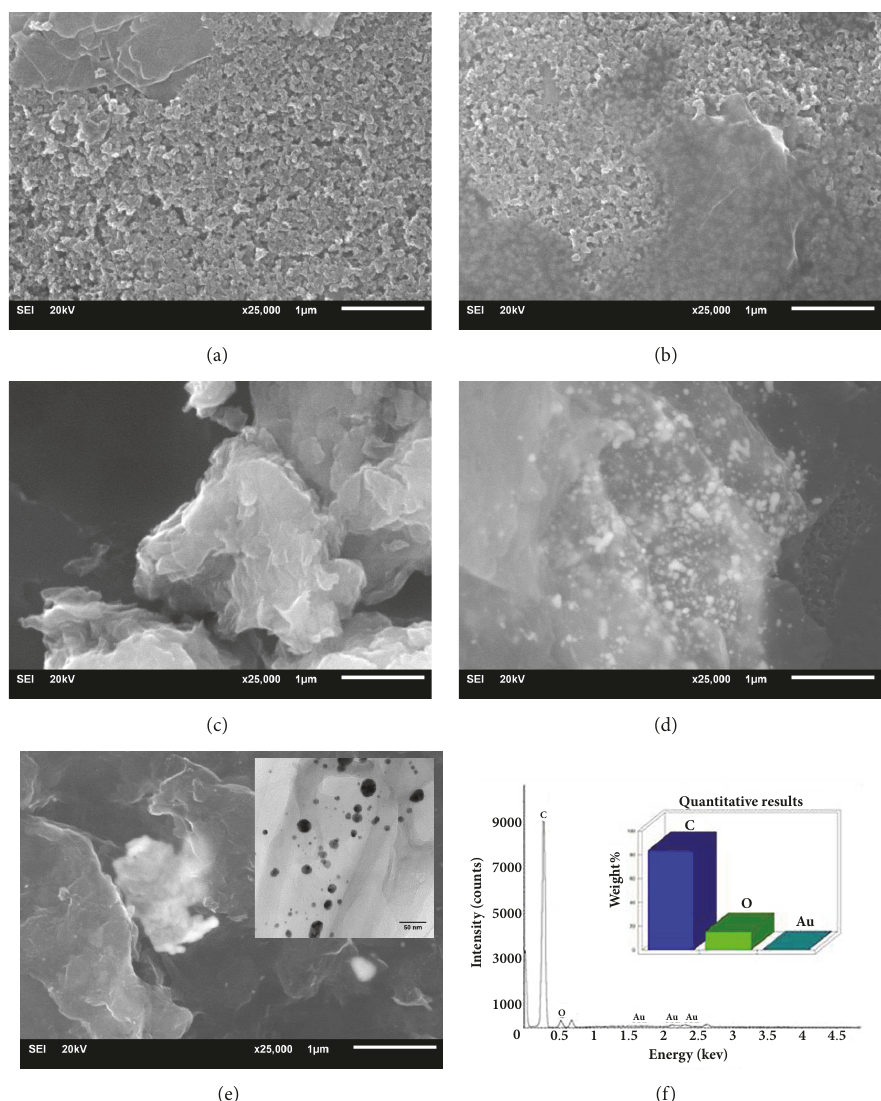
Figure 2: SEM images of (a) bare SPCE, (b) GO, (c) PDA-rGO, (d) rGO/Au, (e) PDA-rGO/Au (inset of Figure 2(e) shows TEM image), and (f) EDX pattern and its corresponding quantitative analysis of